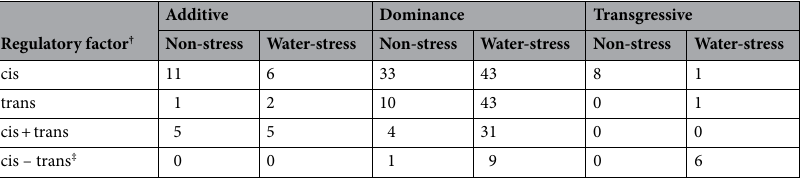
Table 3. Number of transcript isoforms diverging in cis and/or trans regulatory factors explaining additive, dominance, and transgressive under non- and water-stress conditions. † Transcript isoforms exhibiting ambiguous and conserved regulation were excluded from this analysis. ‡ To avoid over-dispersion due to ‘0’ values in the succeeding modelling of these counts, opposing or contrasting interactions were combined (antagonistic and compensating).